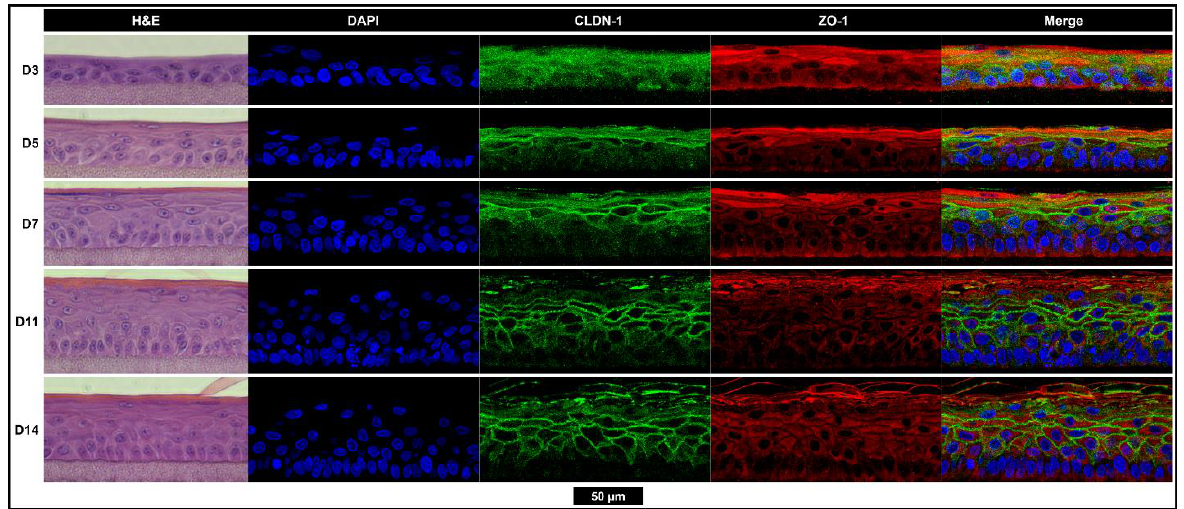
Figure 2. Tissues are morphologically fully developed after 11 days of growth with the strong expression of tight junction proteins CLDN-1 and ZO-1. The hematoxylin and eosin (left), nuclear (blue), CLDN-1 (green), and ZO-1 (red) staining of epidermis-like stratified keratinocyte tissues grown while exposed to the air–liquid interface for 3, 5, 7, 11, or 14 days. All images scaled to match the black scale bar (50 µm). CLDN-1, claudin- 1; D, day; DAPI, 4′,6 -diamidino-2-phenylindole; H&E, hematoxylin and eosin; ZO-1, zona occludens-1.